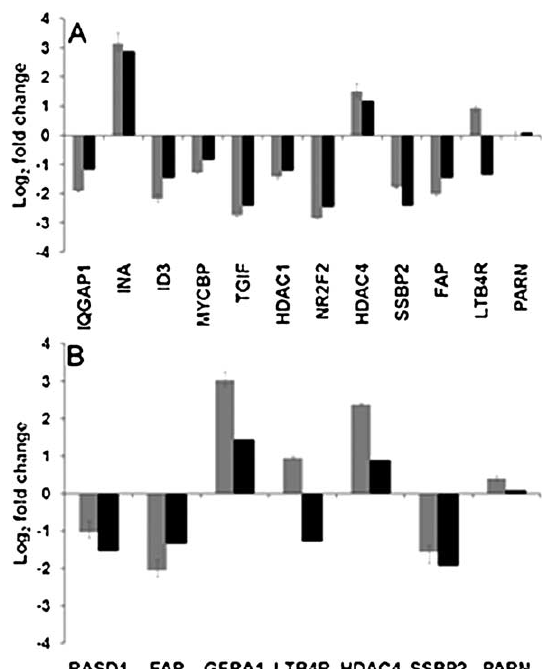
Fig. 3. Real-time PCR analysis of differentially expressed genes. (A) Samples grouped by 1p / 19q status, (B) samples grouped by response. Bars represent the mean relative gene expression of tu- mors with loss of 1p / 19q divided by the mean relative gene expres- sion of tumors with intact 1p / 19q (A) or mean relative gene ex- pression of responders divided by the mean relative gene expres- sion of non-responders (B). This mean fold change in expression was log2 transformed. Following log2 transformation equal levels of gene expression have a value of zero and a two-fold difference has an absolute value of 1. Grey bars ( ), differential expression measured by real-time PCR. Black bars ( ), differential gene ex- pression from microarray analysis of the same tumor samples avail- able for PCR. All genes were significantly differentially expressed ( p (cid:3) 0 . 05, Mann–Whitney U -test), except LTB4R and RASD1 for RT-PCR measurements and PARN for both